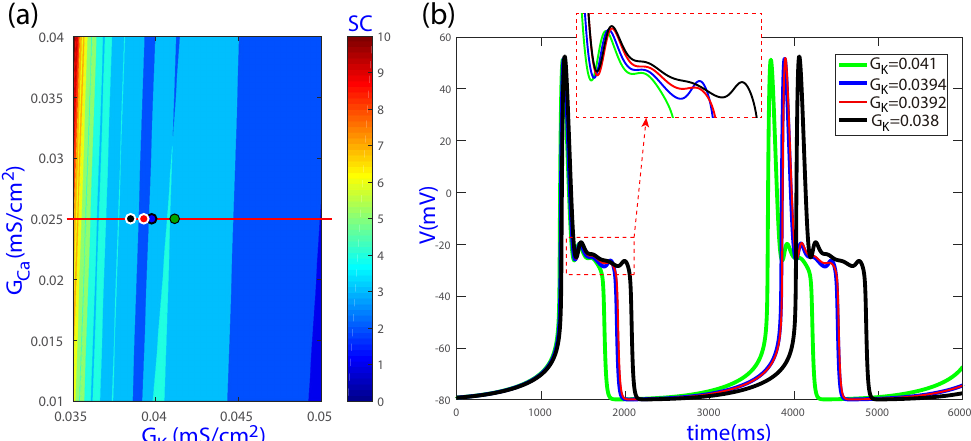
Figure 6. ( a ) Magnification of the spike-adding plot of Figure 2 using a different color scale; and ( b ) some selected beats illustrating how the number of counted spikes can decrease due to the threshold on voltage set in the spike-counting algorithm, even if the number of oscillations is not